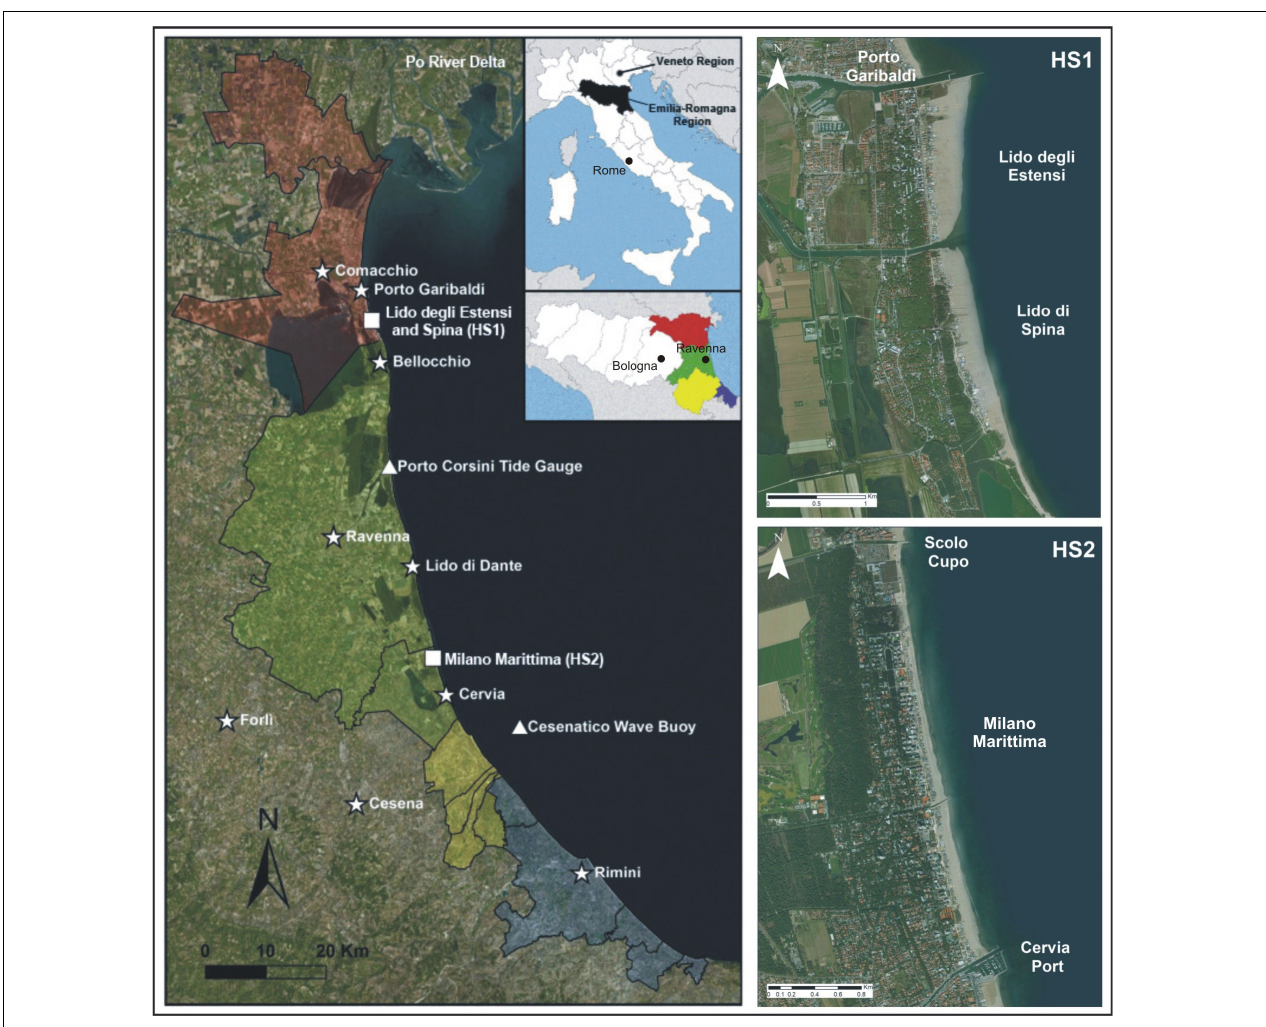
FIGURE 1 | Coastal area of the Emilia Romagna region. The localities cited in the text are indicated. On the right: Lido degli Estensi-Lido di Spina (HS1) and Milano Marittima (HS2). The different colors in the inset indicate the four coastal provinces (modified from Armaroli and Duo,